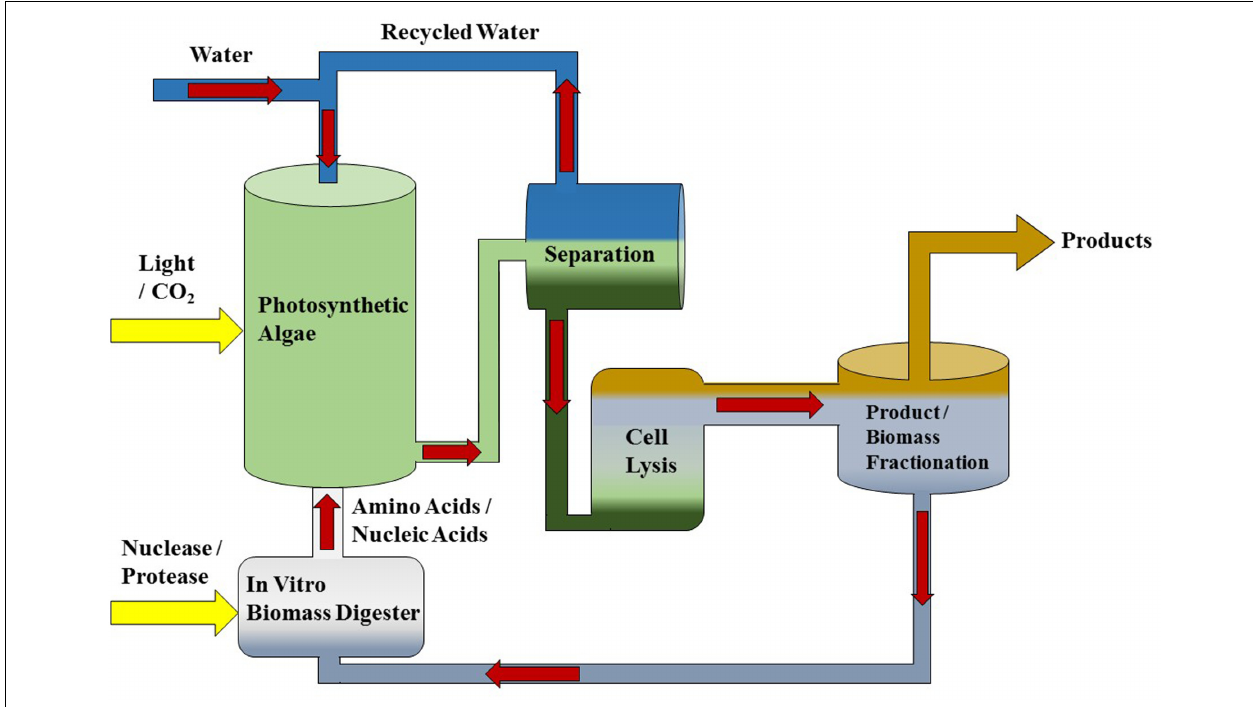
FIGURE 1 | Diagram of a microalgae production system featuring in vitro biomass recycling. This production system is intended to work with any photosynthetic microalgae platform such as Dunaliella that produces extractable lipids or high value co-products. In vitro nutrient recycling is performed in a separate bioreactor to generate N and P organic monomers from algal biomass that are intended as a substitute for fertilizer additions.